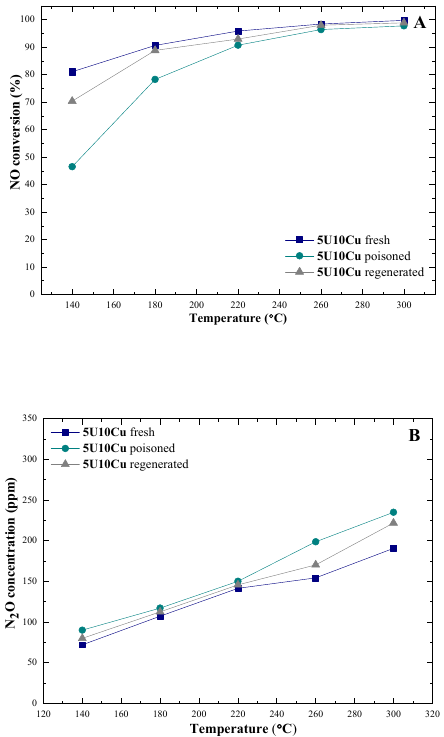
Figure 9. Results of catalytic tests carried out over fresh, poisoned, and regenerated 5U10Cu: ( A ) NO conversion; ( B ) N 2 O concentration.